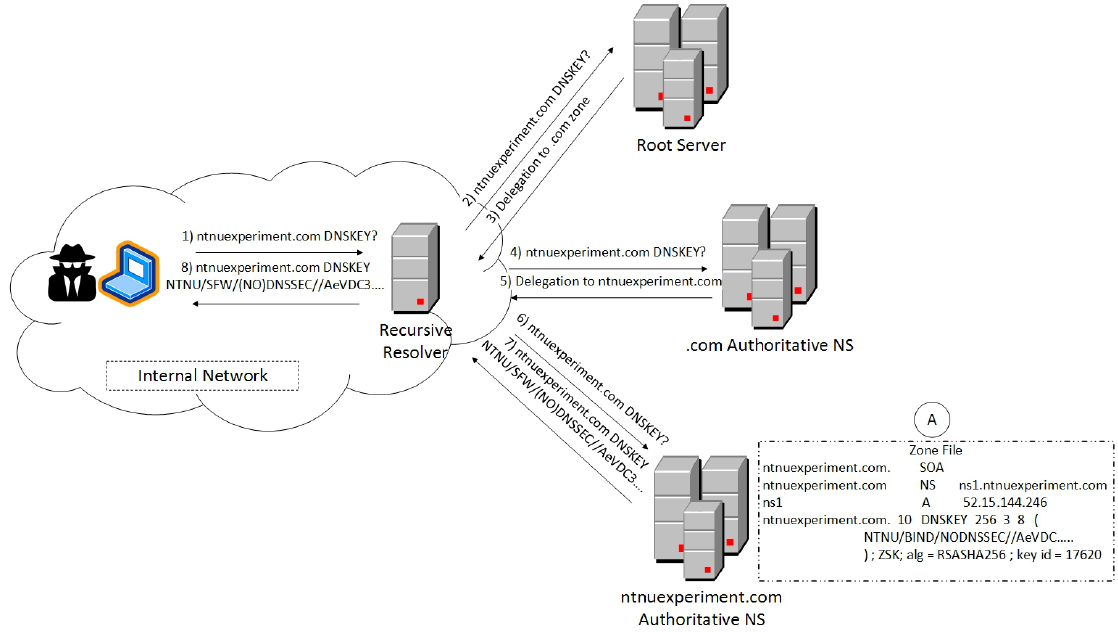
Figure 1. Proposed covert channel